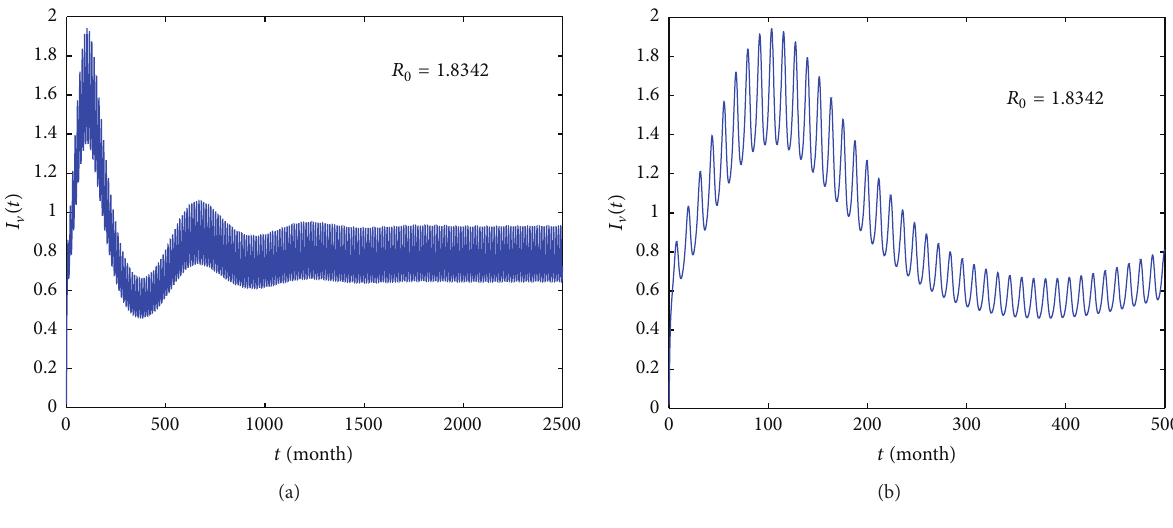
Figure 4: It is similar to Figure